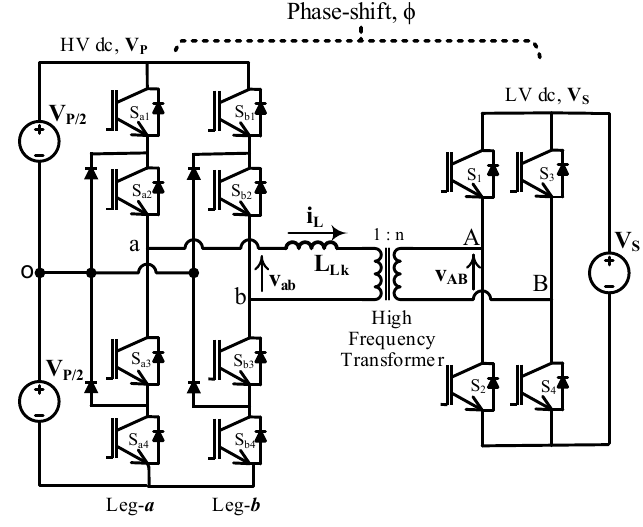
) is of 5L. (cid:3028)(cid:3029)